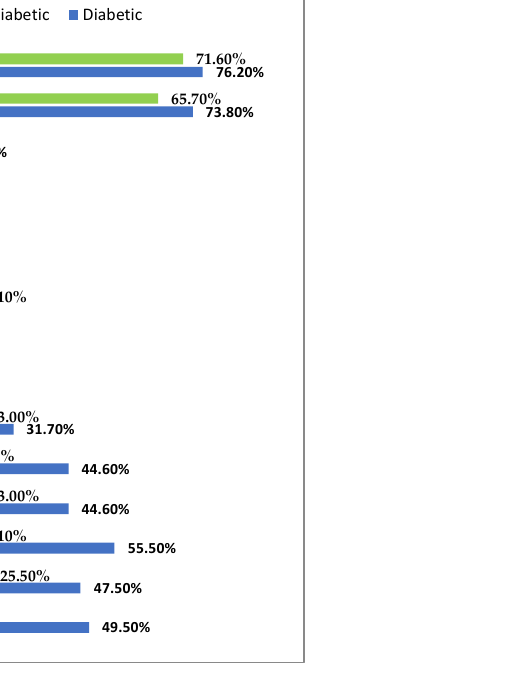
Figure 2. Distribution of cases according to biological parameters outside the limits of normality.